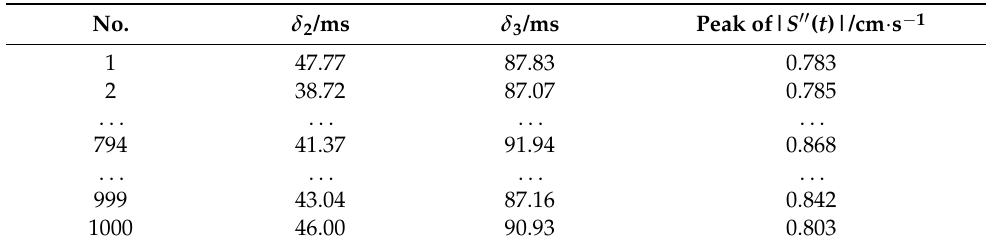
Table 2. The results of solving for the maximum value of vibration velocity when the charge amount was 1.2 kg in a single hole.